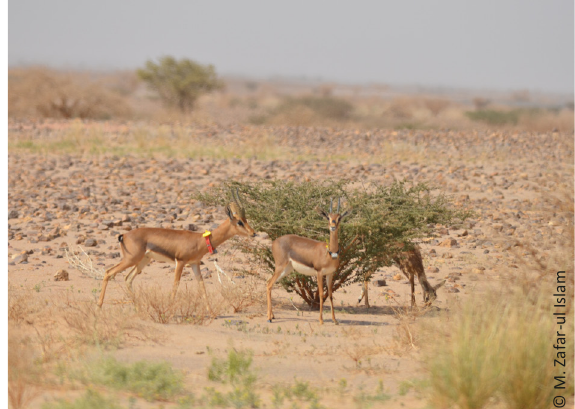
l a I s u l r - f a Z a M . ©